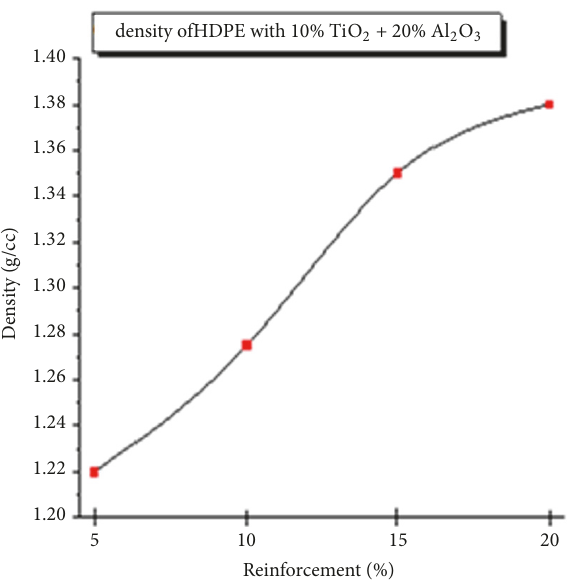
Figure 7: Density varying with %